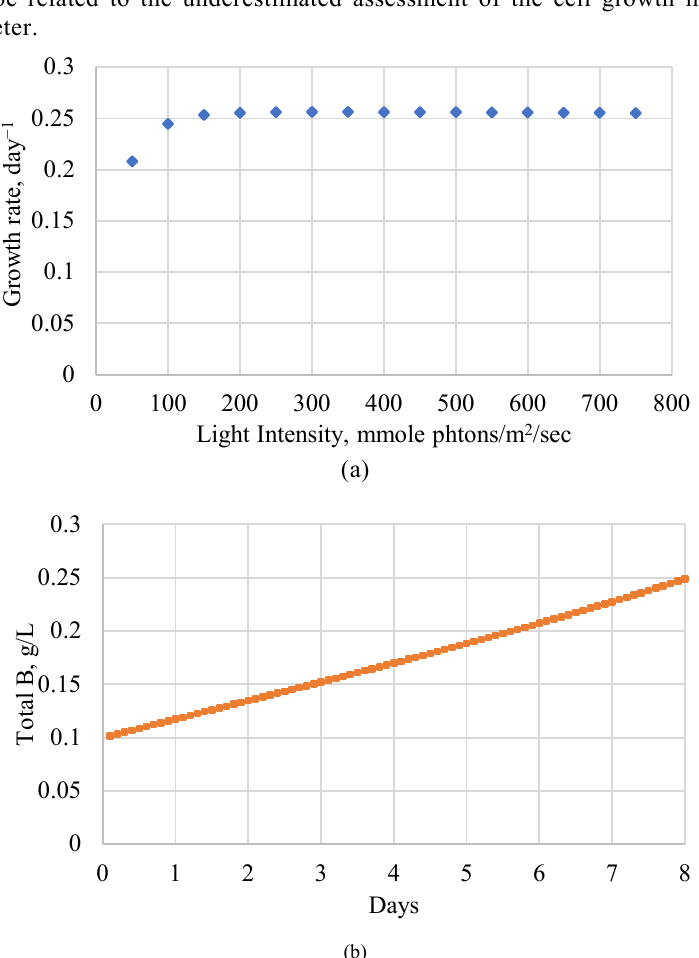
Fig. 7. (a) Calculation of the growth rate changes for different incident light intensities; (b) biomass concentration during the exponential